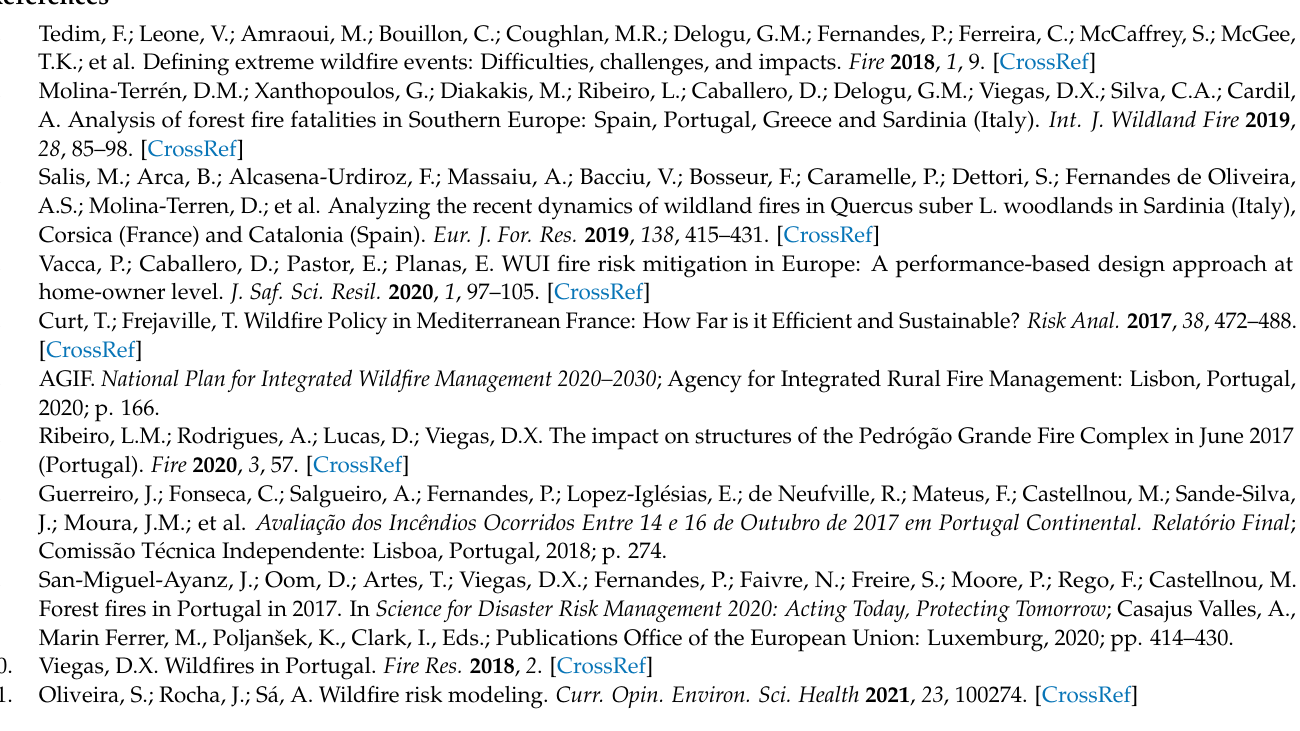
Figure A2. Methodological flowchart of the wildfire risk assessment process implemented in this study. We intersected the fire modeling and spread modeling outputs, including conditional flame length ( CFL ) and annual burn probability ( aBP ), with highly valued natural resources and human assets to assess exposure in mainland Portugal. The wildfire exposure results were summarized in communities using socioeconomic data, and we described the burning recurrence and intensity by IUCN land designation class in the natural sites.